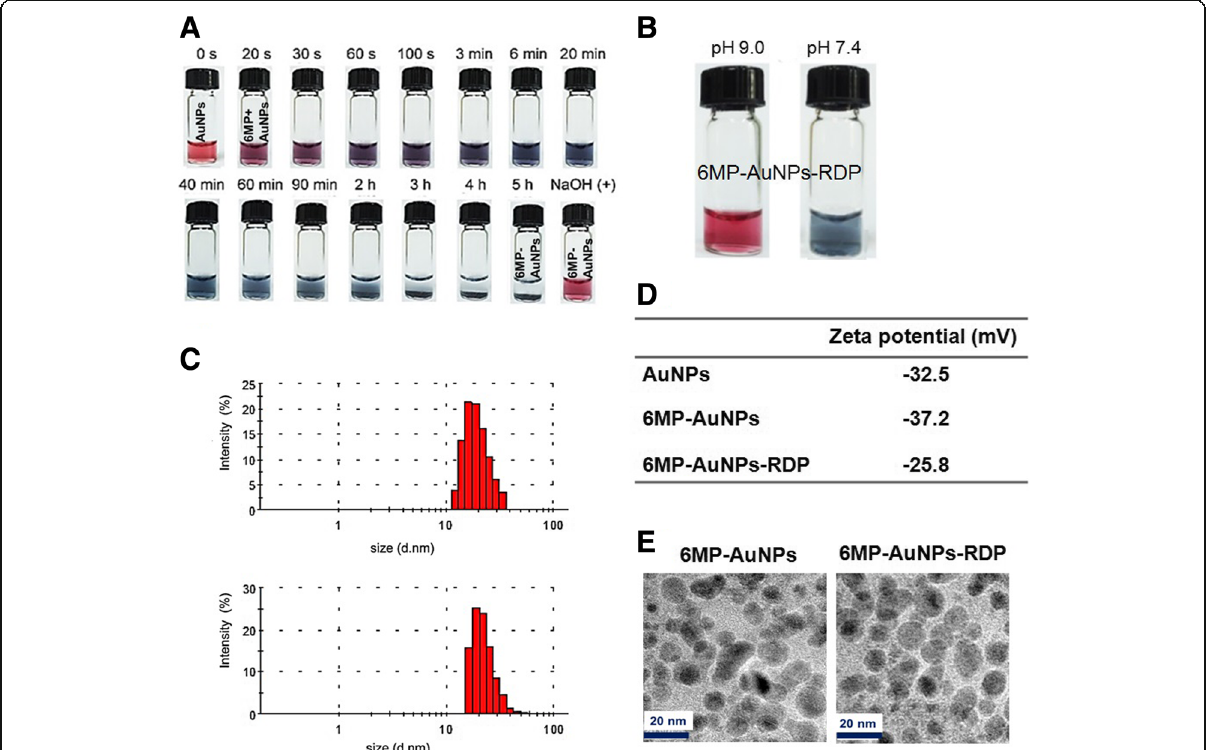
Fig. 2 Reaction process and characteristics of the nanoparticles. a Reaction process for preparing 6MP-AuNPs. After 6MP was added into AuNP solution, the solution color changed and precipitation was gradually formed in 5 h. b 6MP-AuNPs-RDP precipitation was dissolved when pH was adjusted to 9.0 by 0.1 M NaOH. c DLS measurement of size distribution of the particles. d Zeta potential of AuNPs, 6MP-AuNPs, and 6MP-AuNPs-RDP. e Particle structures under